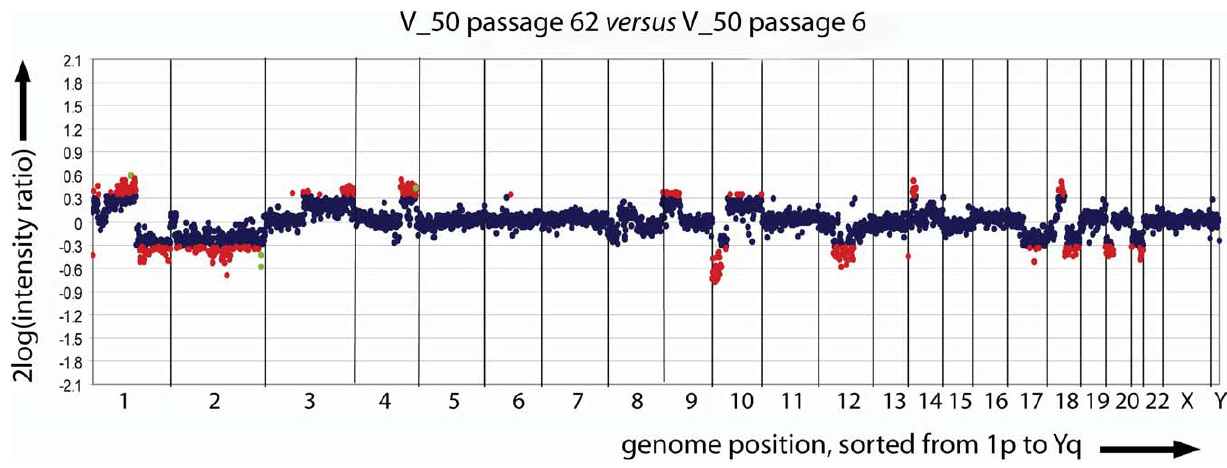
Figure 6. Genomic instability of the 143B host nucleus as revealed by array-CGH. Array-CGH was at 1 Mb resolution with a BAC/PAC array using genomic DNAs from V_50 P62 and V_50 P6 as test DNA and reference DNA respectively. Red, blue and green dots represent, respectively, copy number change, no copy number change and natural copy number variations. Numbers on the X-axis represent human chromosome numbers.